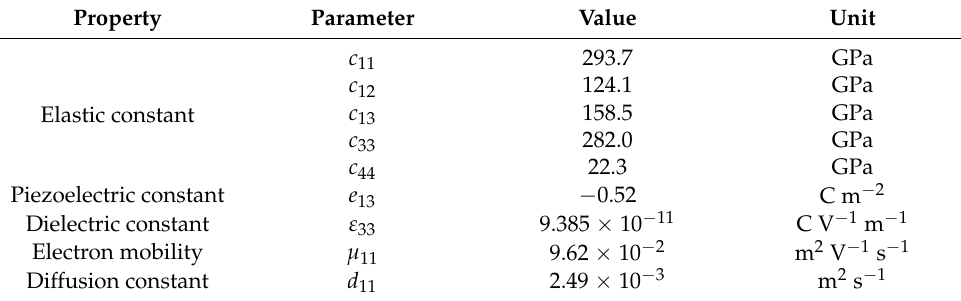
Table 1. The elastic, piezoelectric, and dielectric constants of GaN. Property